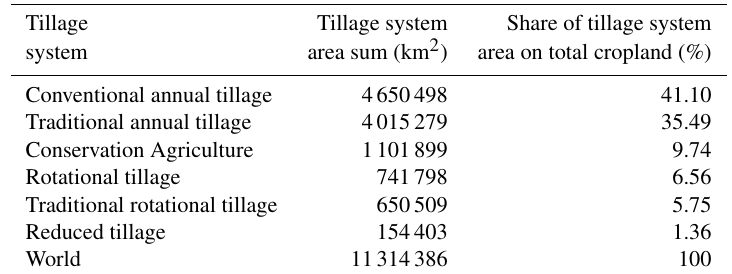
Table 4. Global aggregated tillage system areas and shares on total cropland (IFPRI/IIASA, 2017b).